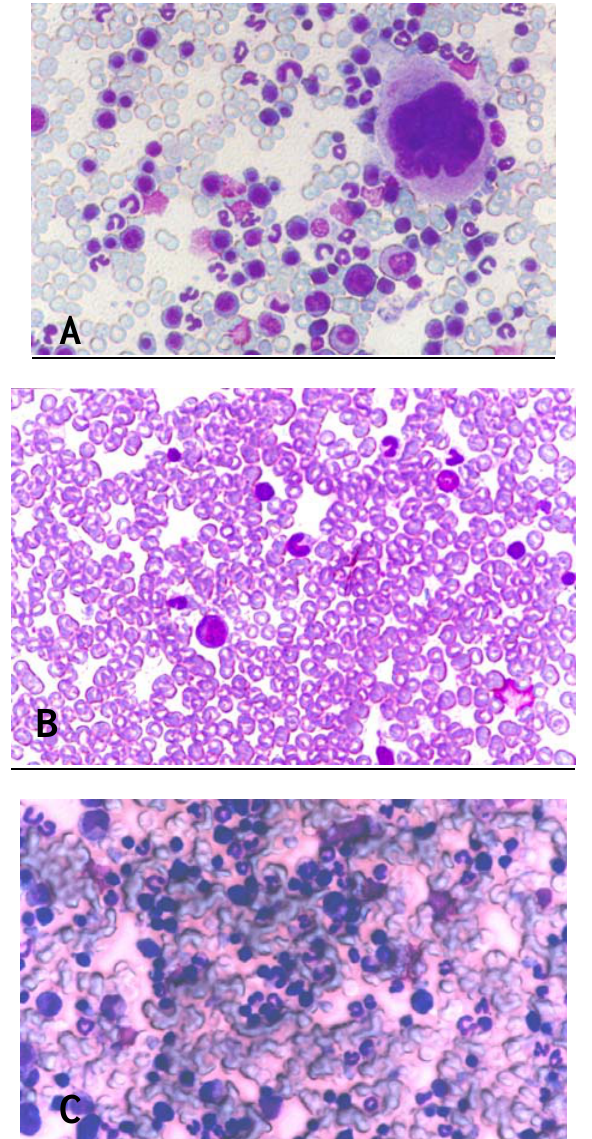
Figure 1. A: Bone marrow with normal cells at control moment (Leishman stain – 400x); B: Hypocellular bone marrow 6h after crotalic venom administration (Leishman stain – 400x); C: Bone marrow with normal cells 72h after crotalic venom administration (Leishman stain –